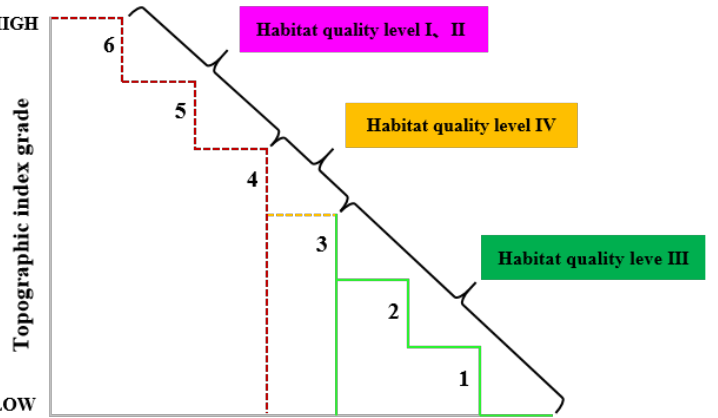
Figure 10. Main distribution differences of habitat quality in various topographic positions.